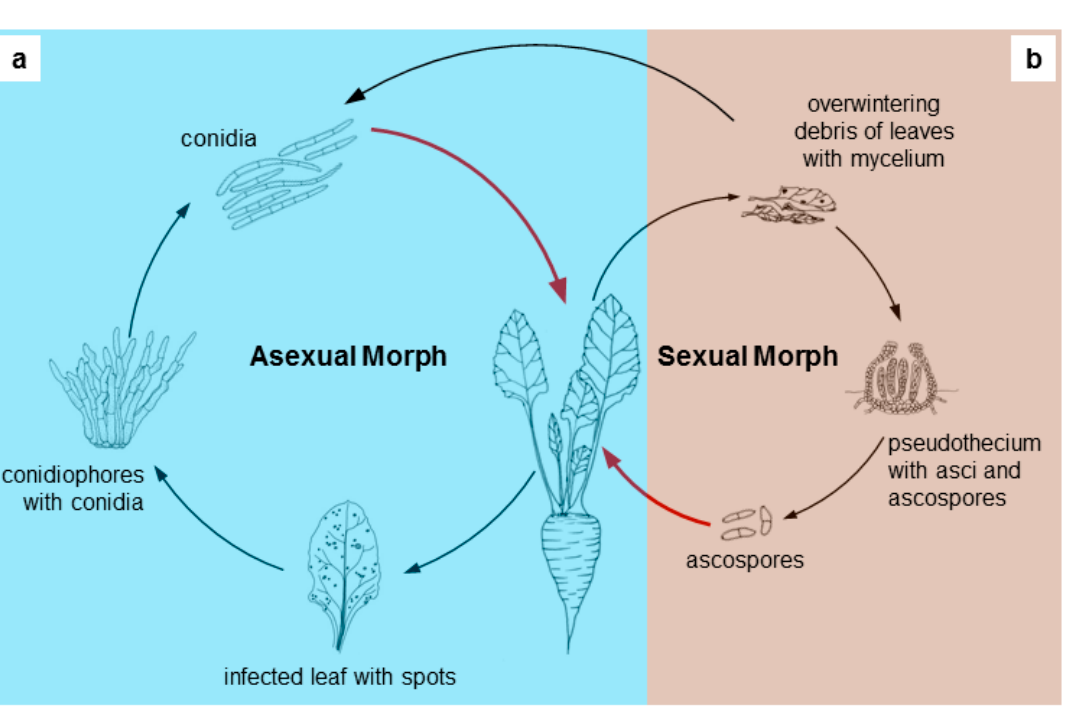
Figure 1. Scheme of the life cycle of cercosporoid fungi: ( a ) blue part—asexual; ( b ) brown part—sexual (if occurs). Red arrows—infection process.